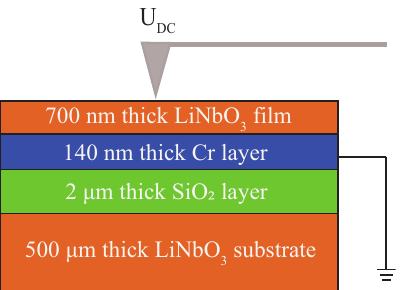
Figure 1. Schematic diagram of the LNOI structure and the domain poling in LNOI with an AFM tip voltage U DC